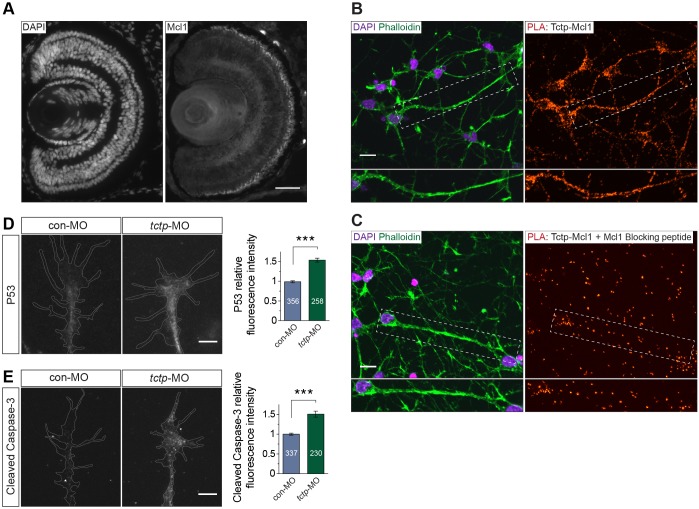
Axonal Tctp interacts with pro-survival Mcl1. (A) Coronal section of stage 43 retina probed with an anti-Mcl1 antibody and counterstained with DAPI. (B,C) PLA signal for Tctp and Mcl1 in cultured rat cortical neurons (E18.5+3 DIV) counterstained with DAPI and phalloidin. The boxed areas are enlarged beneath. In C, anti-Mcl1 serum and blocking peptide were co-incubated before proceeding with the assay. (D) Representative control and Tctp morphant RGC growth cones stained for P53. Mean±s.e.m.; n, number of growth cones analysed; ***P=0.0002, unpaired t-test. (E) Representative control and Tctp morphant RGC growth cones stained with an antibody that specifically recognises the cleaved (activated) form of Caspase-3. Mean±s.e.m.; n, number of growth cones analysed; ***P=0.0002, unpaired t-test. Scale bars: 50 μm in A; 10 μm in B,C; 5 μm in D,E.